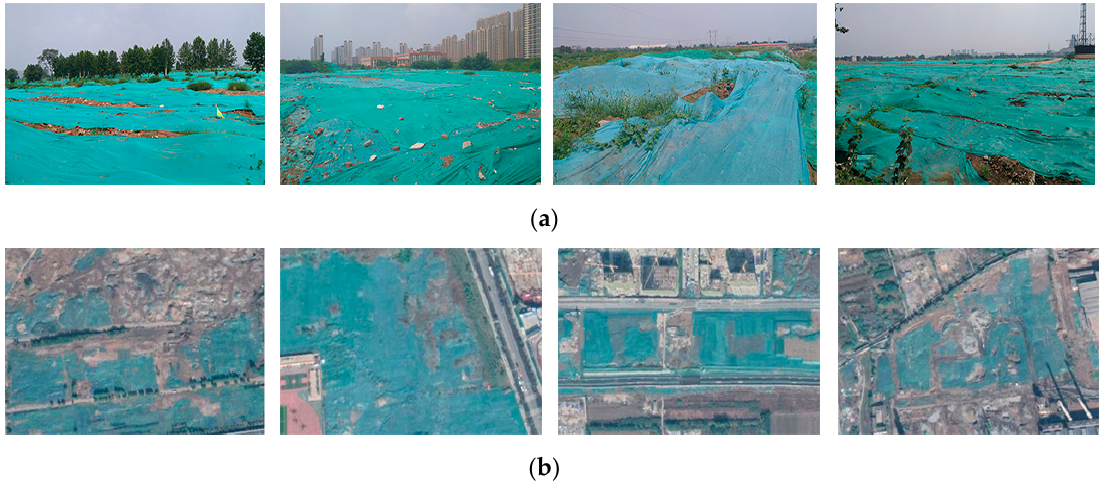
Figure 1. Green plastic covered regions: ( a ) On-site photos; ( b ) VHR remote sensing images.